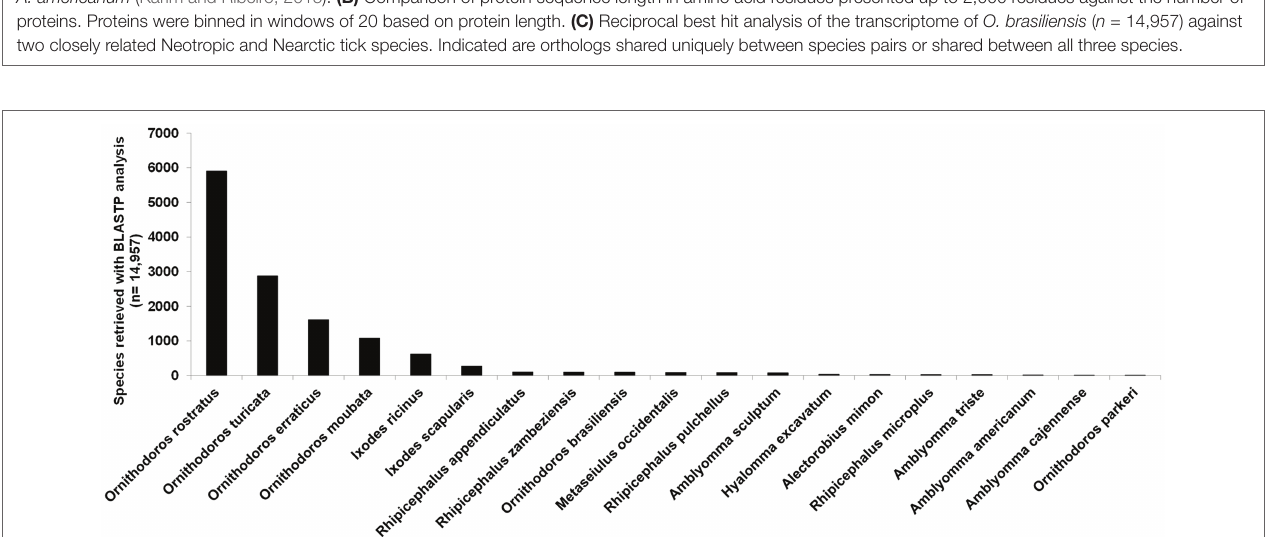
FIGURE 2 | BLASTP analysis of 14,957 contigs against the ACARI database. Species with more than 10 hits are